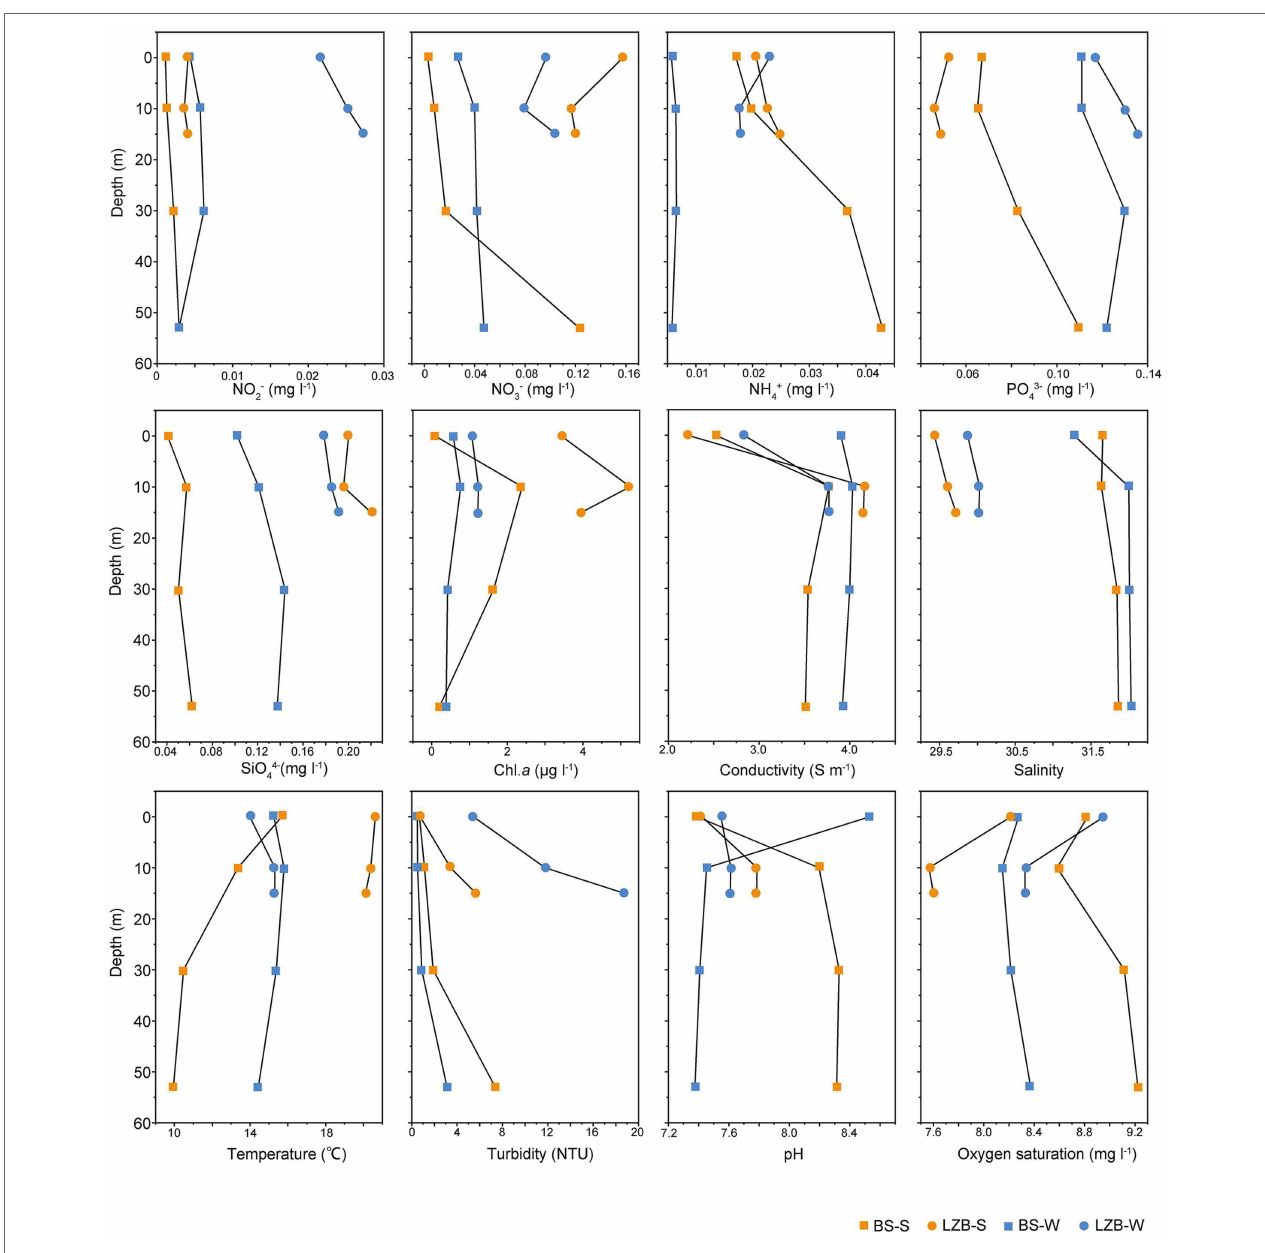
FIGURE 1 | Environmental variables in the studied stations of Bohai